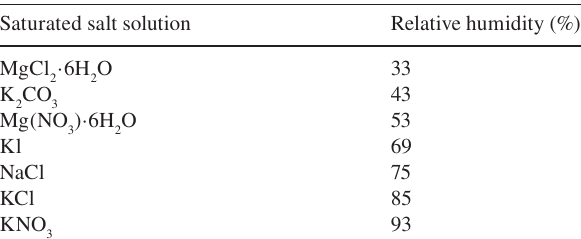
Table 4 Relationship between saturated salt solution used and relative humidity.